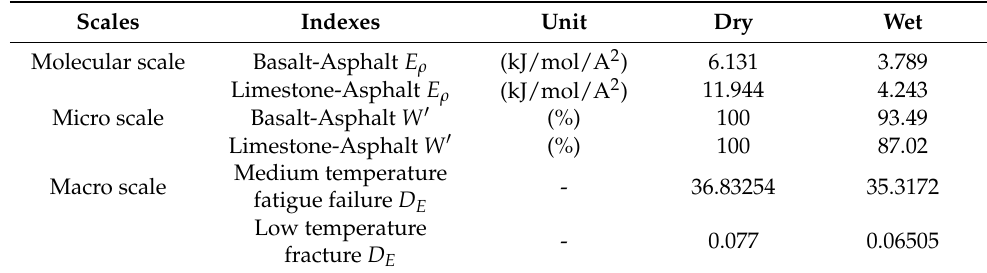
Figure 18. Multiscale association analysis. Table 12. Multiscale indices of the influence of water.